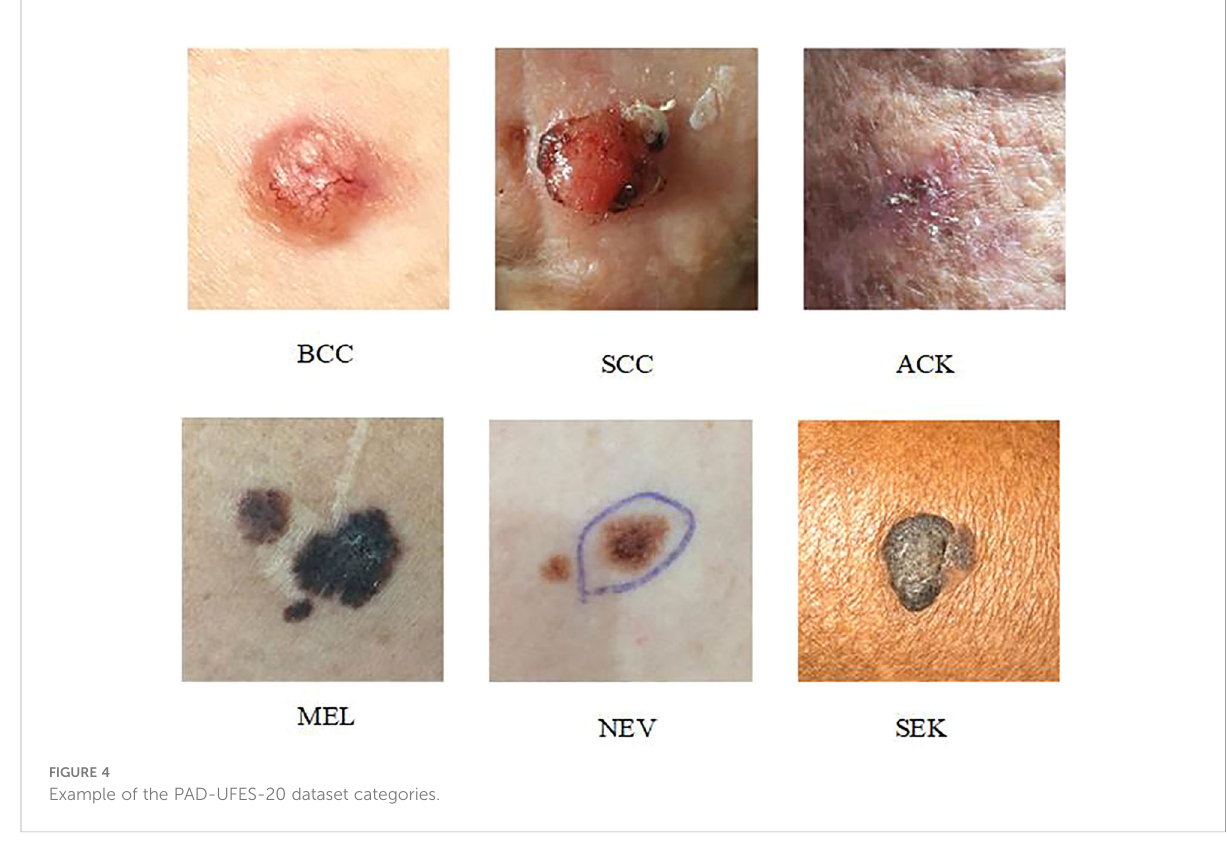
FIGURE 4 Example of the PAD-UFES-20 dataset categories.